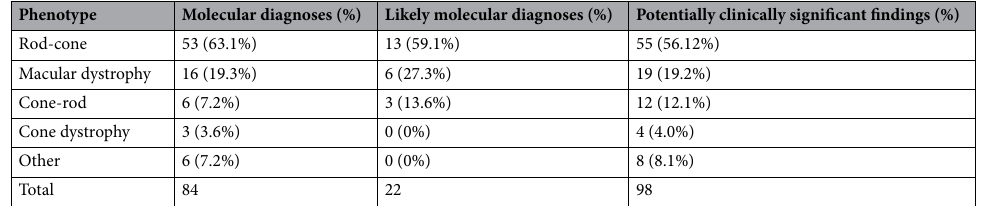
Table 1. Molecular diagnosis and likely molecular diagnosis in our